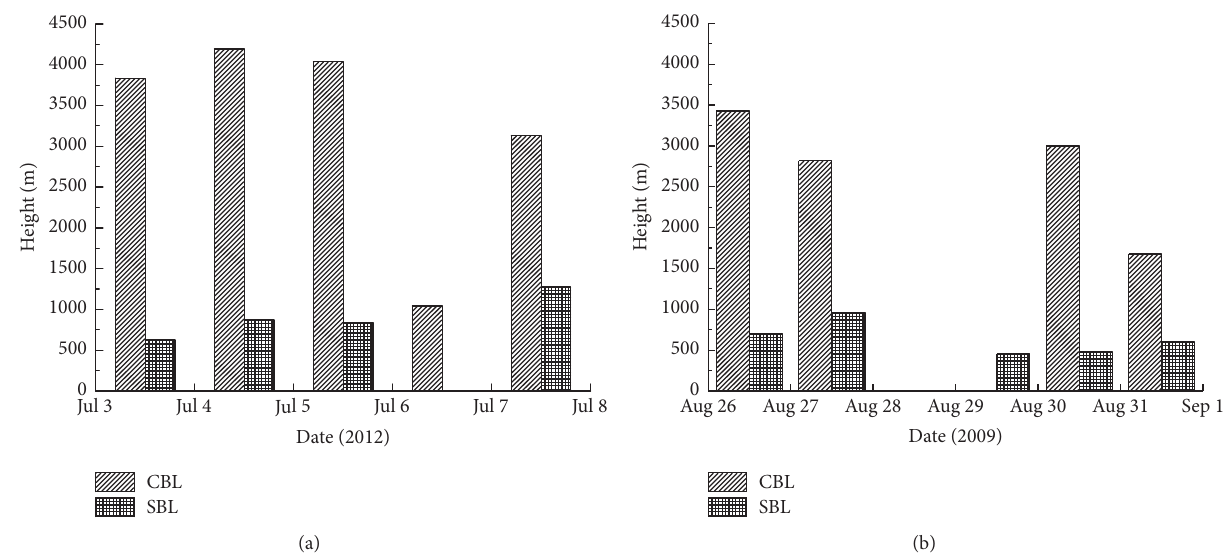
Figure 5: Daily maximum thickness variation of CBL and SBL: (a) midsummer in 2012 and (b) late summer in 2009.